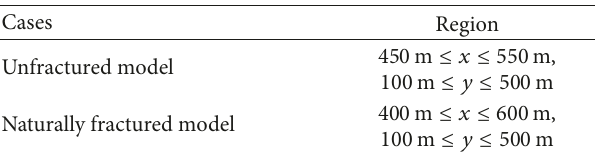
Table 3: Region of intensive mesh for multiple perforations in staged hydraulic